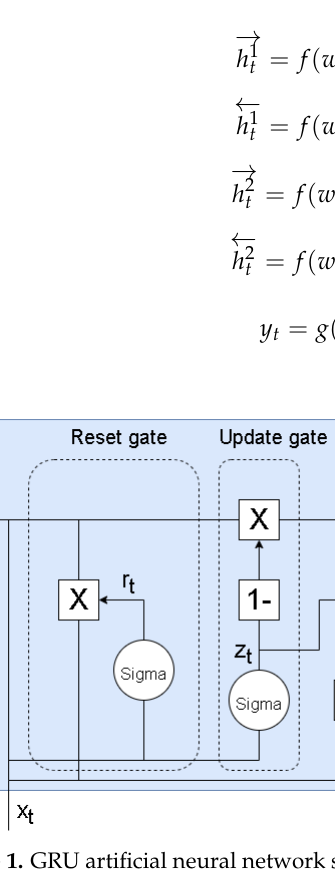
Figure 1. GRU artificial neural network structural unit.